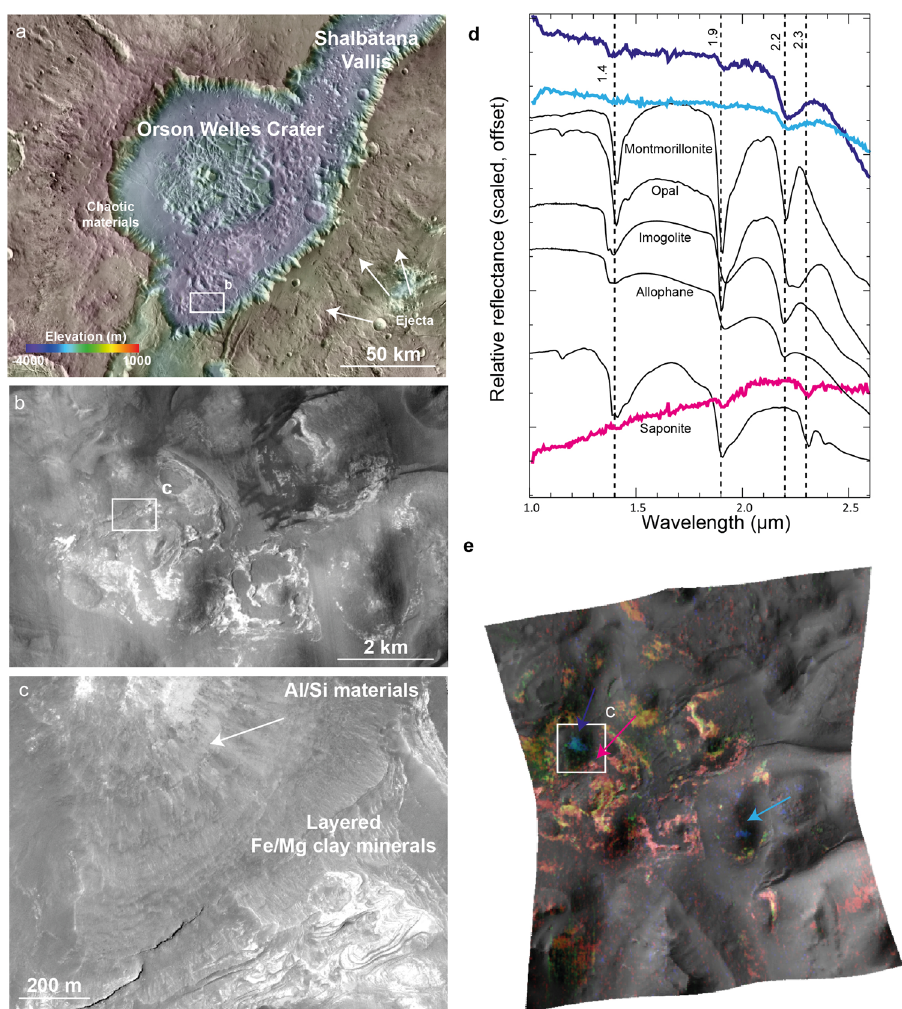
Fig. 6 The youngest known example of compositional stratigraphy on Mars. a The geology context of compositional stratigraphy on the chaotic materials in the Orson Welles crater. MOLA elevation data draped over THEMIS daytime infrared data (warm colors are higher elevations and cool colors are lower elevations). The white arrows indicate the presence of impact ejecta. b The CTX shows the overview of layered light-toned compositional stratigraphy. c Close-up HiRISE image shows the morphology and texture of compositional stratigraphy. d CRISM spectra extracted from regions of interest are shown as offset ratio spectra compared to laboratory spectra of relevant minerals. e The CRISM parameter map shows the distribution of alteration minerals, Fe/ Mg phyllosilicate in red/yellow and Al phyllosilicate in blue. The different color arrows show locations of spectra